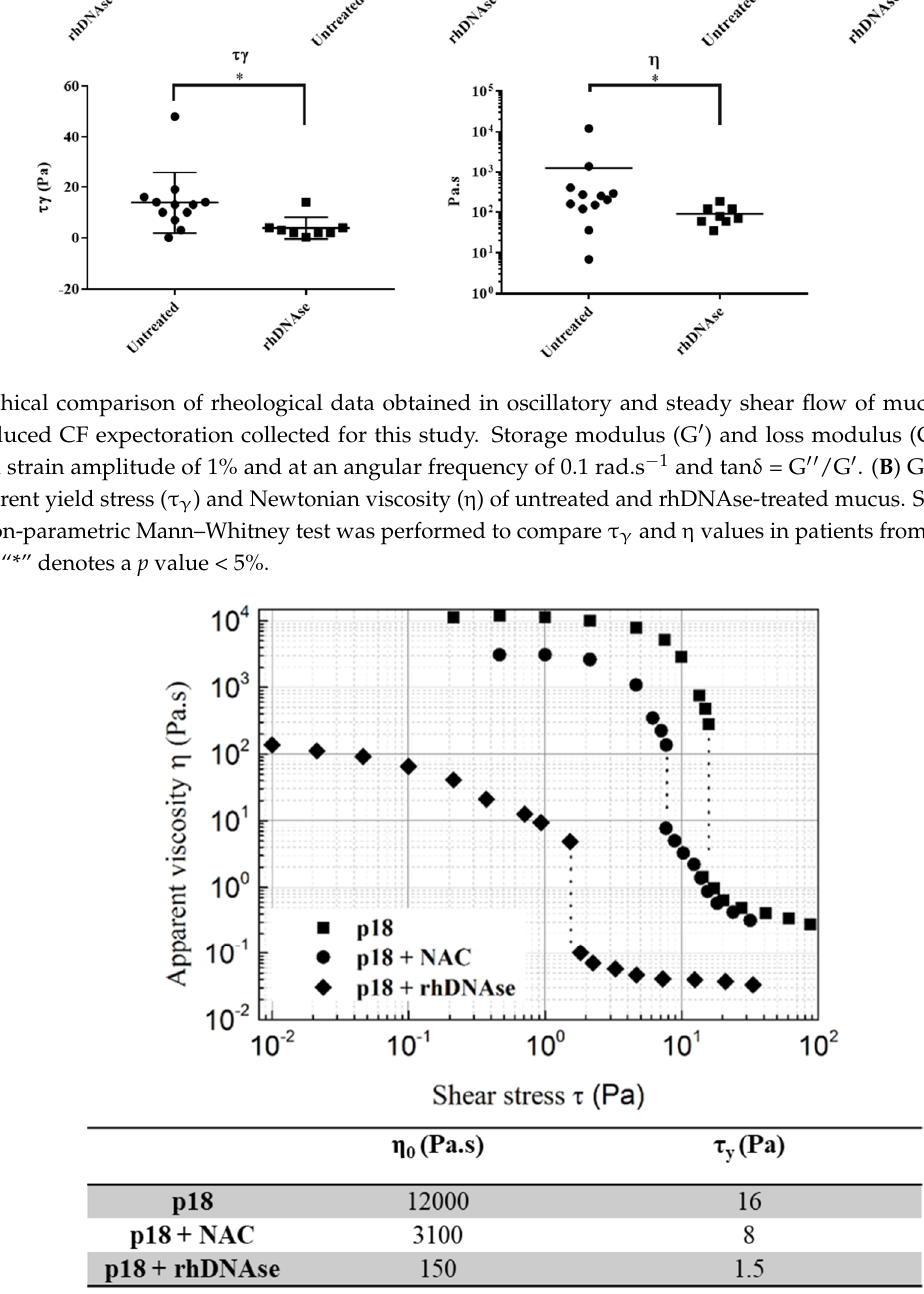
Figure 3. Flow curves, Newtonian viscosity (η 0 ) and apparent yield stress ( τ γ ) of sputum collected from p18 (collected without rhDNAse induction) and treated or not with either rhDNAse or N-acetyl-cysteine (NAC). The apparent yield stress is defined as the stress at the flow curve near discontinuity.